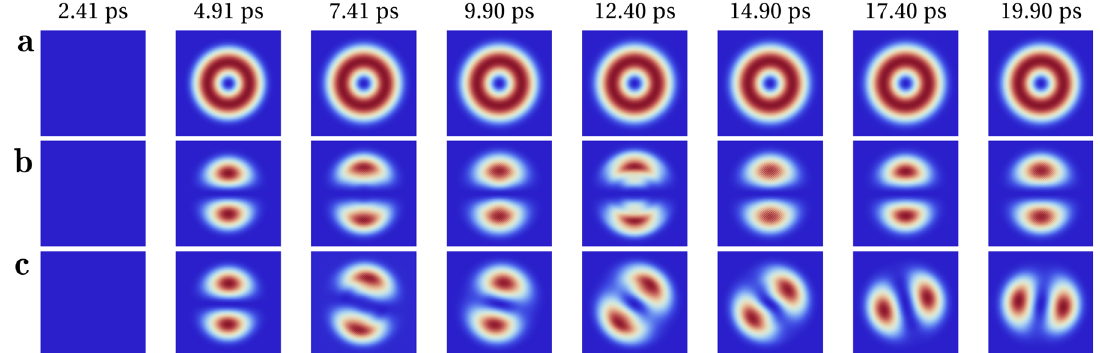
Fig. 8 Time evolution of the out-of-plane ISHE signal. Twisted magnon waves with different compositions are generated in the NiO waveguide. a Shows the reference signal, which is the z -component of the spin accumulation according to the ISHE is calculated via (cid:5) n ´ ∂ I s t n . b Shows the superposition of two twisted modes of opposite topological charge but for a small difference in the frequencies: f 1 = 0.5 THz, f 2 = 1.1 f 1 . The resulting pattern rotates with the beating